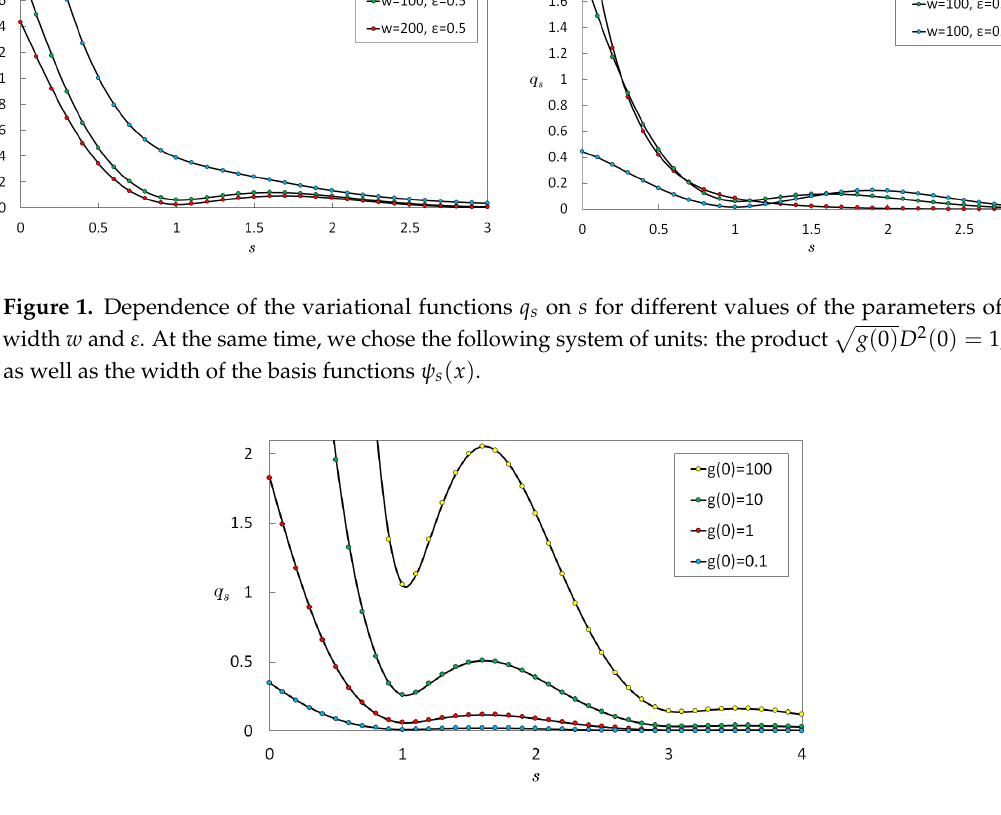
Figure 2. Dependence of the functions q s on s for different values of the amplitude of the coupling constant g ( 0 ) . The parameters w and ε are fixed and equal to w = 100 and ε = 0.5, respectively. The amplitude of the propagator D ( 0 ) = 1 (in this case, the variation of the product means the variation of the g ( 0 )